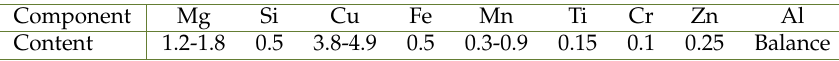
Table 3. Physical and mechanical properties of workpiece